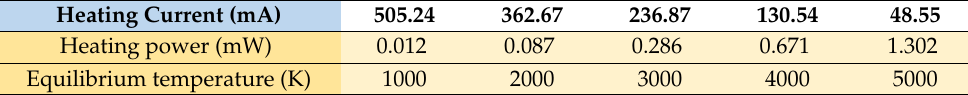
Figure 11. The voltage output curve of the experimental and simulated infrared light sensor at 4000 ppm. Table 2. Power and current values at different simulated